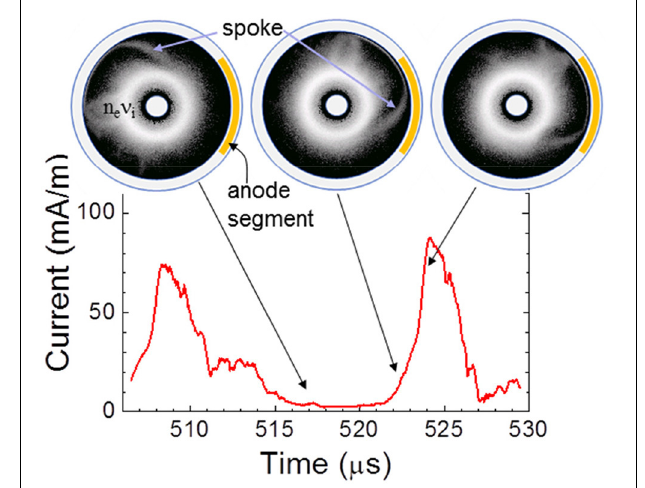
FIGURE 8 | Diagram showing the directions of the electric field E and electron mean velocity and flux in the conditions of Figure 7. The equipotential lines in the plasma (between 380V and the anode potential at 400V) are also shown. The electron flux is mainly in the E × B direction, i.e., parallel to the equipotential lines (with a small component due to collisional drift in the direction opposite to E ), i.e., parallel to the front in the spoke while the direction of the ion flux is close to the electric field direction, i.e., perpendicular to the spoke front in the spoke region.